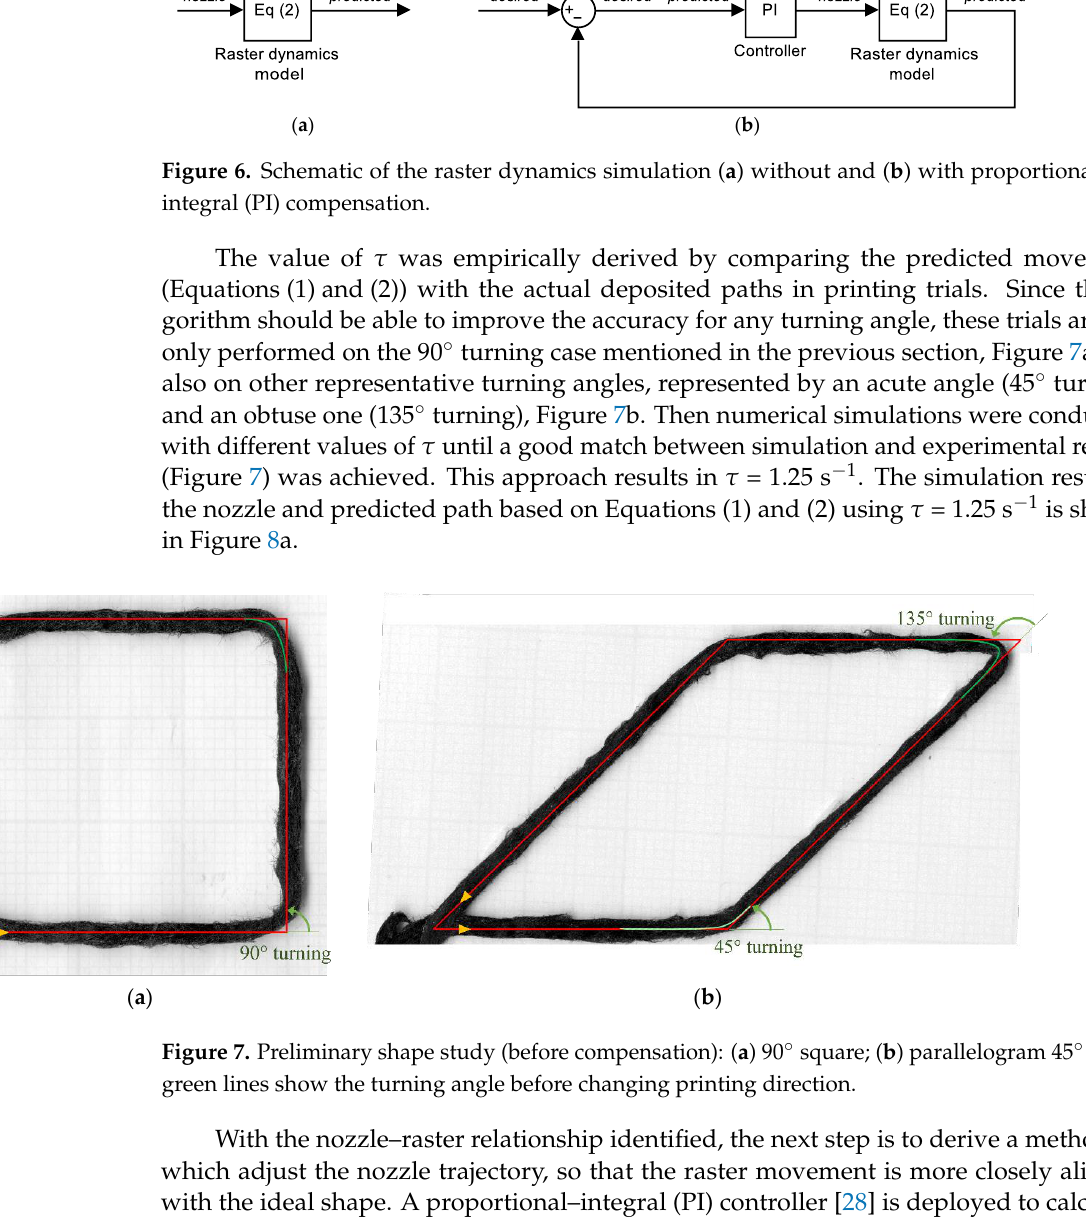
( b ) Figure 8. Simulated nozzle path without ( a ) and with ( b ) compensation, starting from (0,0) and printed following the arrows), showing the predicted raster path. The proportional and integral gains used by the PI controllers in ( b ) are K P = 1.5 and K I = 2.5. With the nozzle–raster relationship identified, the next step is to derive a method by which adjust the nozzle trajectory, so that the raster movement is more closely aligned with the ideal shape. A proportional–integral (PI) controller [28] is deployed to calculate the nozzle path, as shown in the closed feedback loop in Figure 6b. The PI controller then